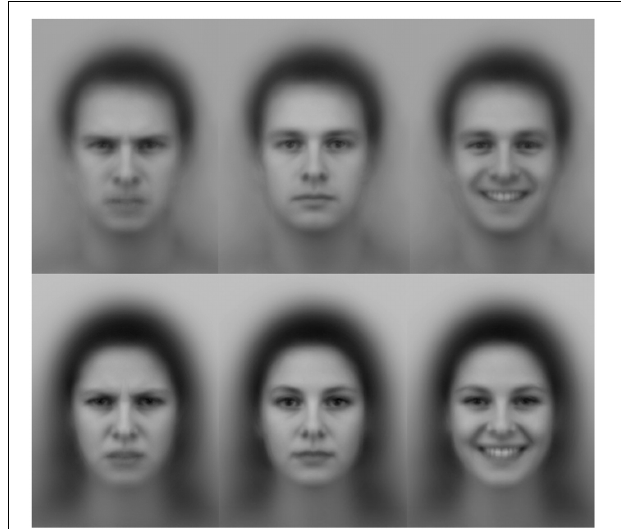
FIGURE 1 | Examples of the face stimuli used in all four tasks. Note: Faces from the Averaged Karolinska Directed Emotional Faces set (Lundqvist and Litton,